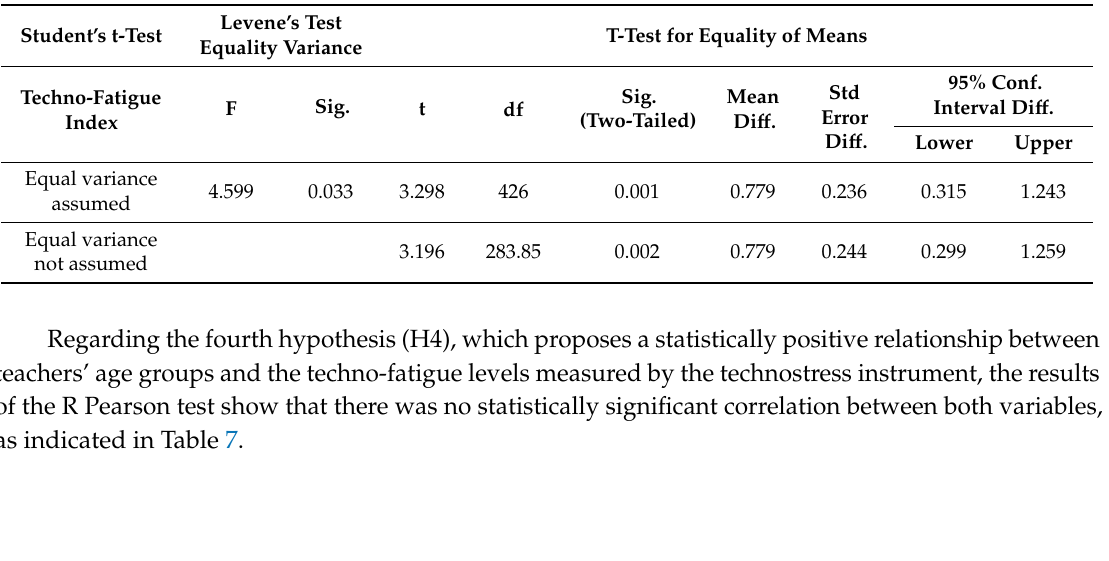
Table 6. Techno-fatigue Student’s